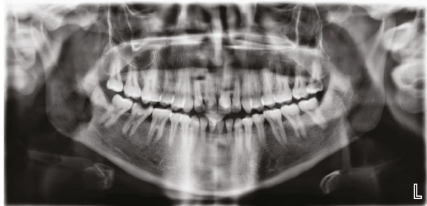
Figure 9: Case 2: dental panoramic tomography (DPT) shows taurodontism in molars.